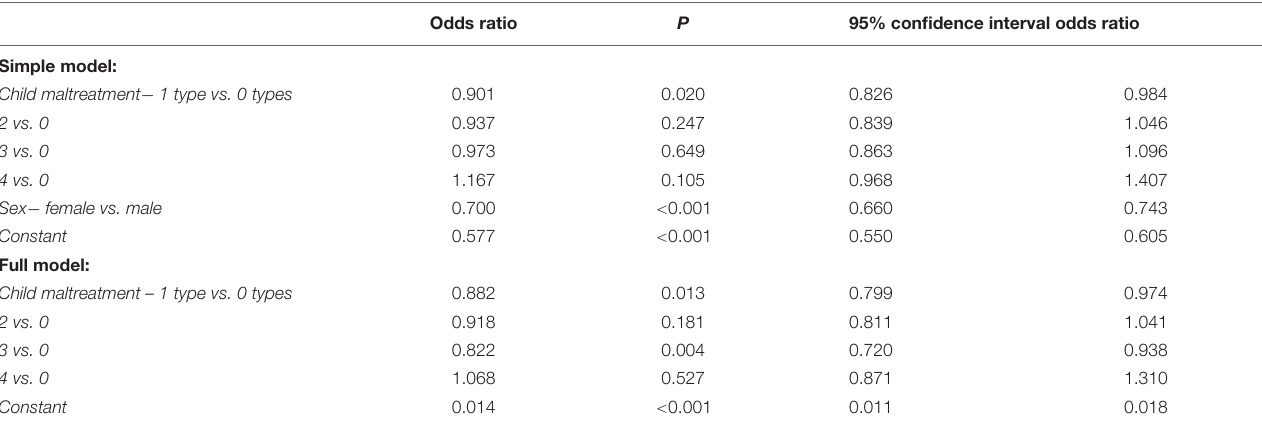
TABLE 4 | Results of the logistic regression analysis assessing the association between the number of experienced child maltreatment types and metabolic syndrome diagnosis in N = 20,714